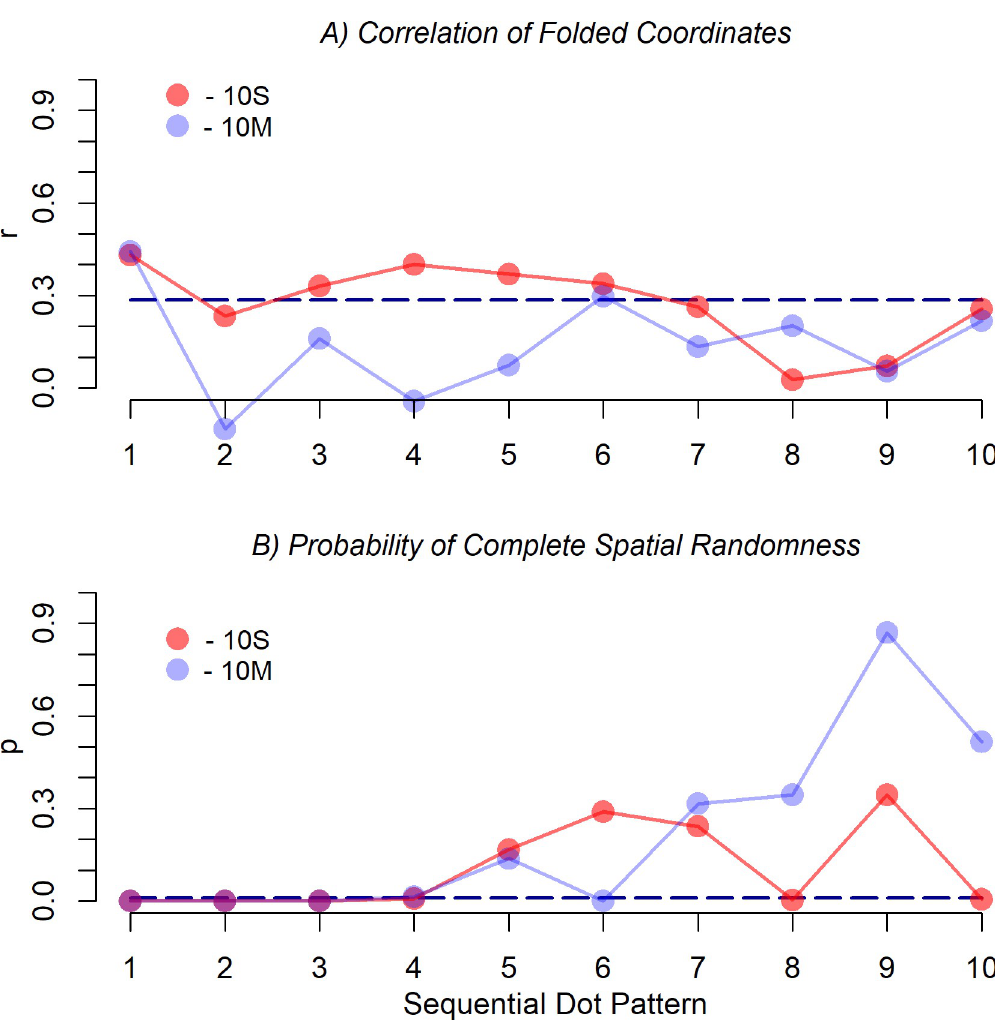
Fig 13. Correlations of the two-times folded coordinates (panel A ) and p -values of the quadrat tests (panel B ) for the successive ten superimposed dot patterns in the two conditions in Experiment 3. The dashed line in the upper graph indicates when a correlation is significant. In the lower panes it indicates p =